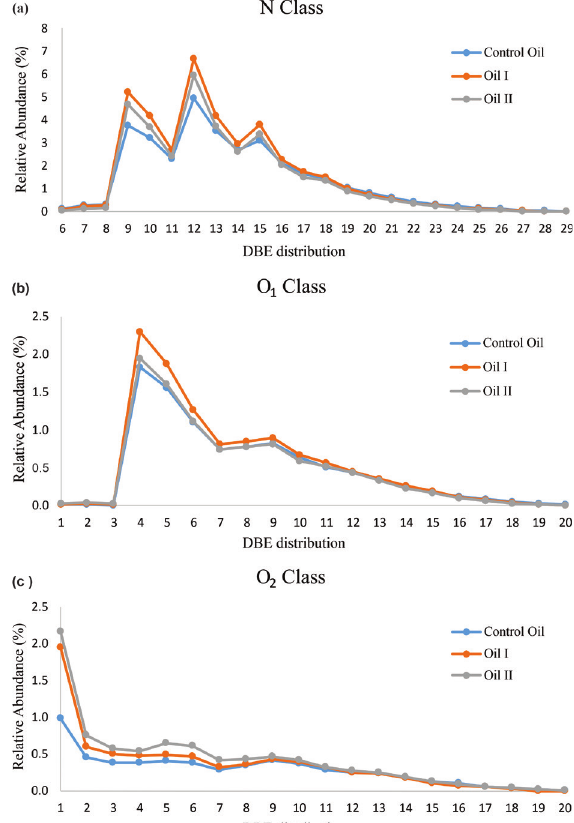
Figure 7. DBE distribution of (a) N, (b) O, and (c) O classes for the oil